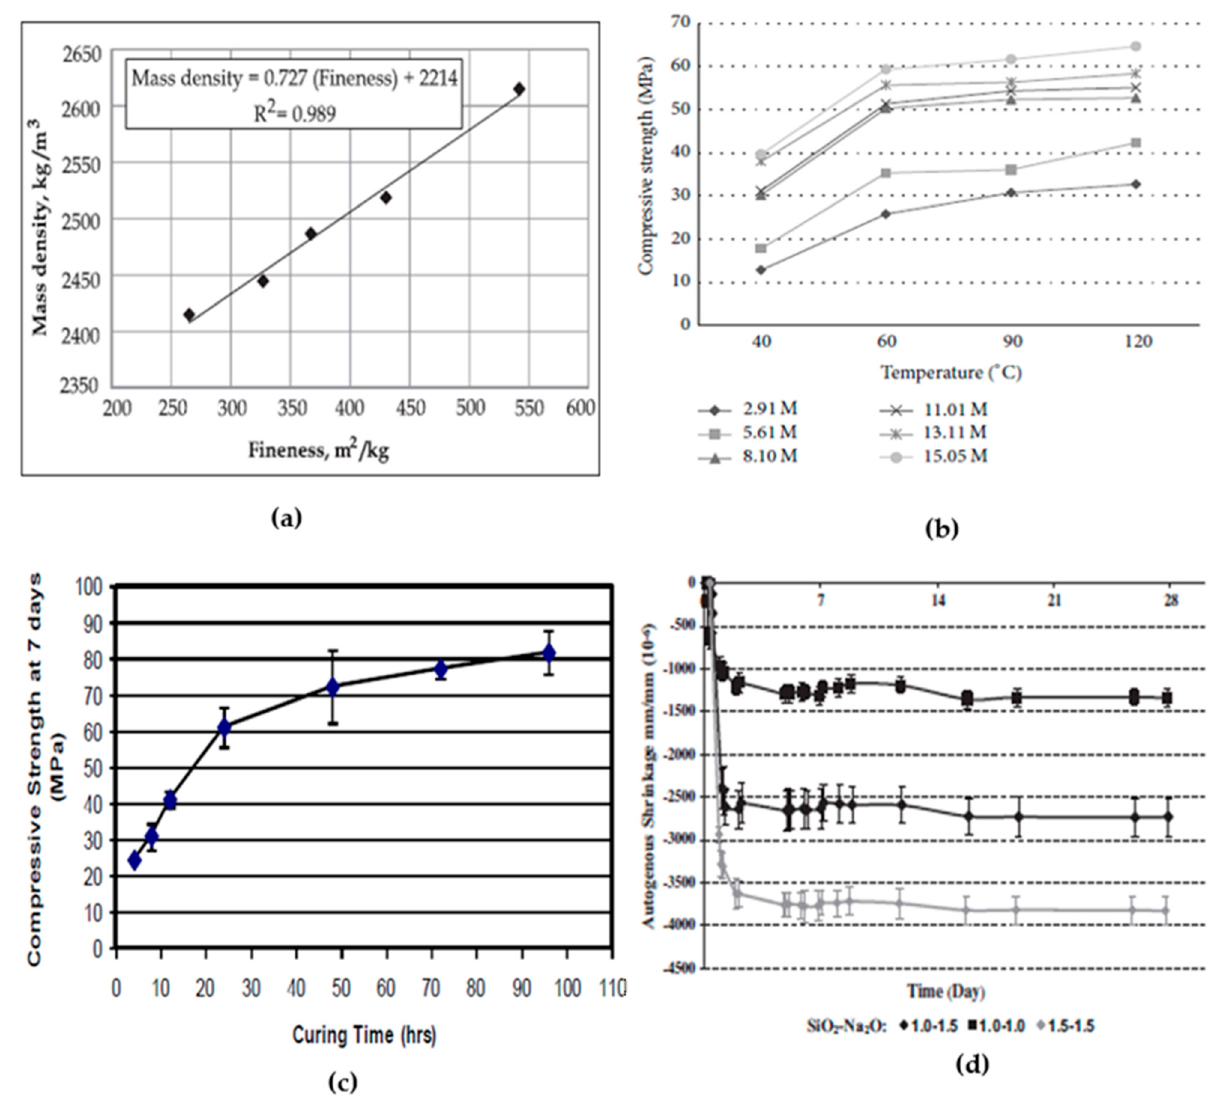
Figure 3. ( a ) Effect of fly ash fineness on mass density; ( b ) effect of degree of heating for different concentrations of NaOH solution on compressive strength at solution ‐ to ‐ fly ash ratio of 0.40 [27]; ( c ) effect of curing time on compressive strength [30]; ( d ) autogenous shrinkage of AAFA pastes with different SiO 2 and Na 2 O content, cured at 40 °C (corrugated tube method, measurement started after the final set, the autogenous shrinkage was the mean value of three replicates for each specimen).